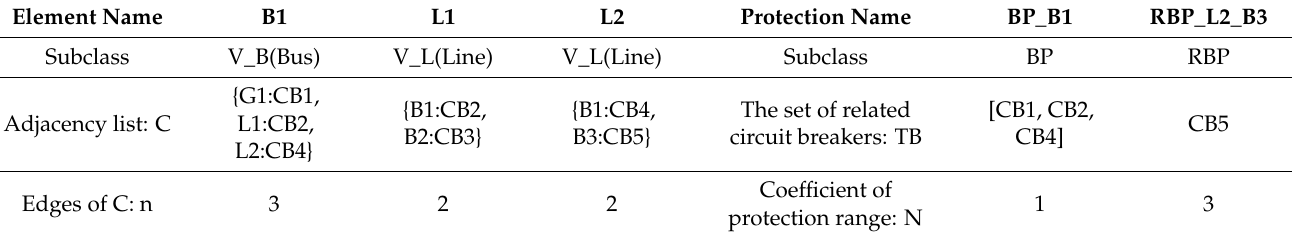
Table 2. Instance representation of B1, L1, L2 and BP_B1, RBP_L2_B3. Table 3. Instance representation of CB1, CB2, CB4 and